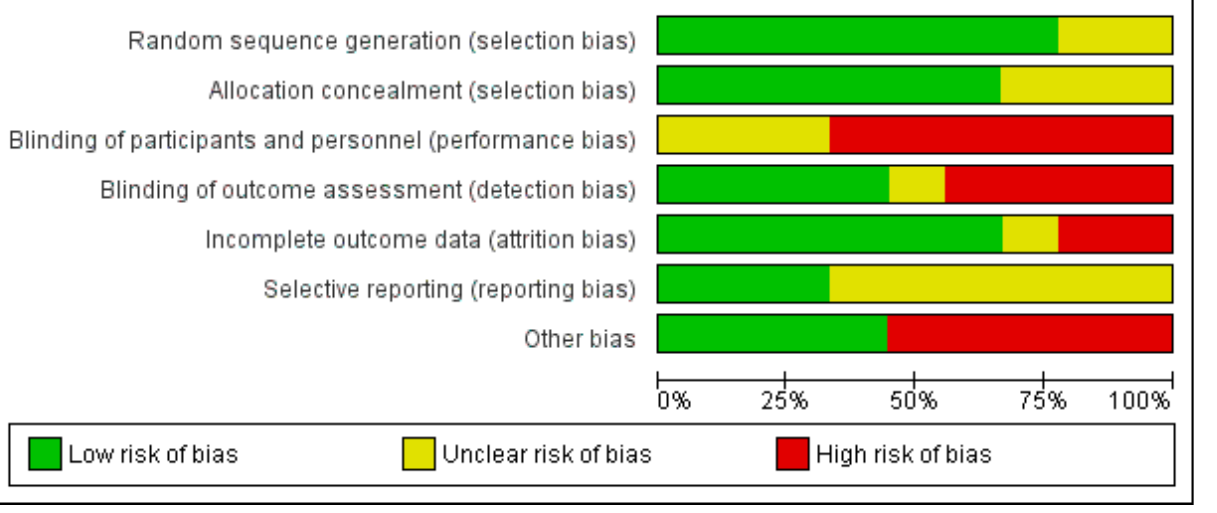
Figure 2. Risk of bias graph: review authors’ judgements about each risk of bias item presented as percentages across all included studies.